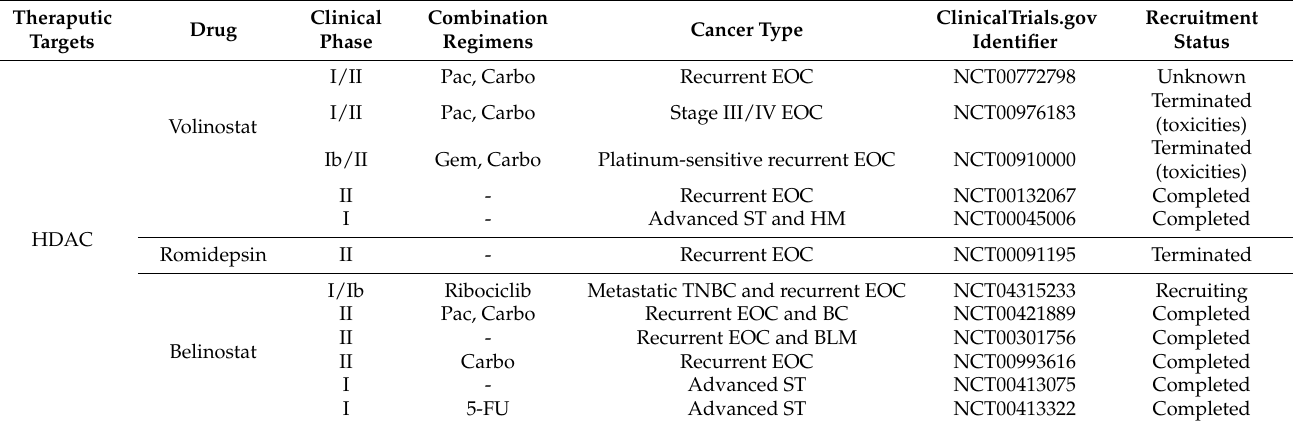
Table 2. Clinical trials of FDA approved HDAC inhibitors in ovarian